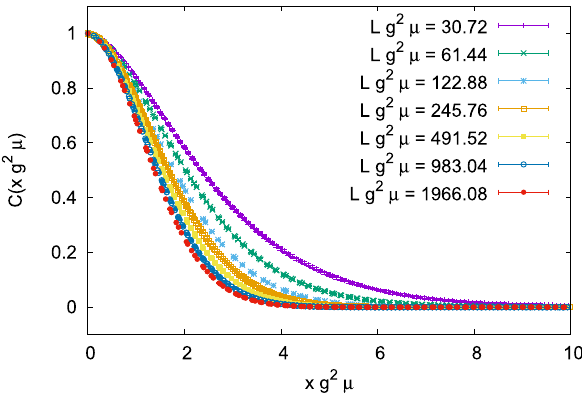
Fig. 2 Dipole amplitude generated from the discretized MV model on the torus with an infrared regulator in a small volume g 2 μ L = 30 . 72. Calculation done using a linear extend of L / a = 512